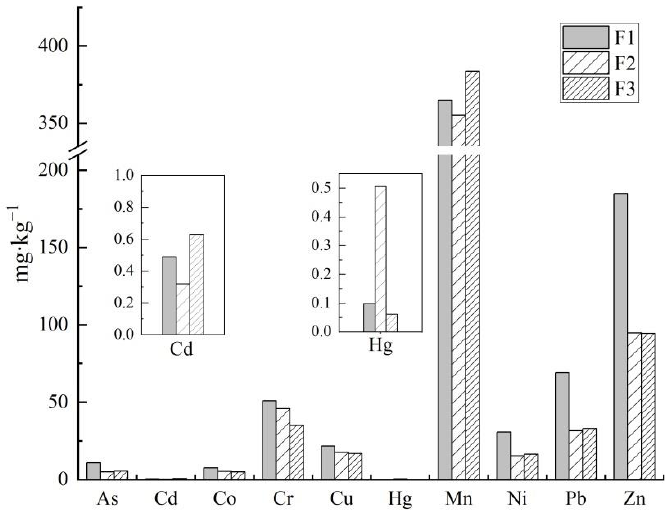
Figure 6. Comparison of heavy metal concentrations for three factories and the BCs.